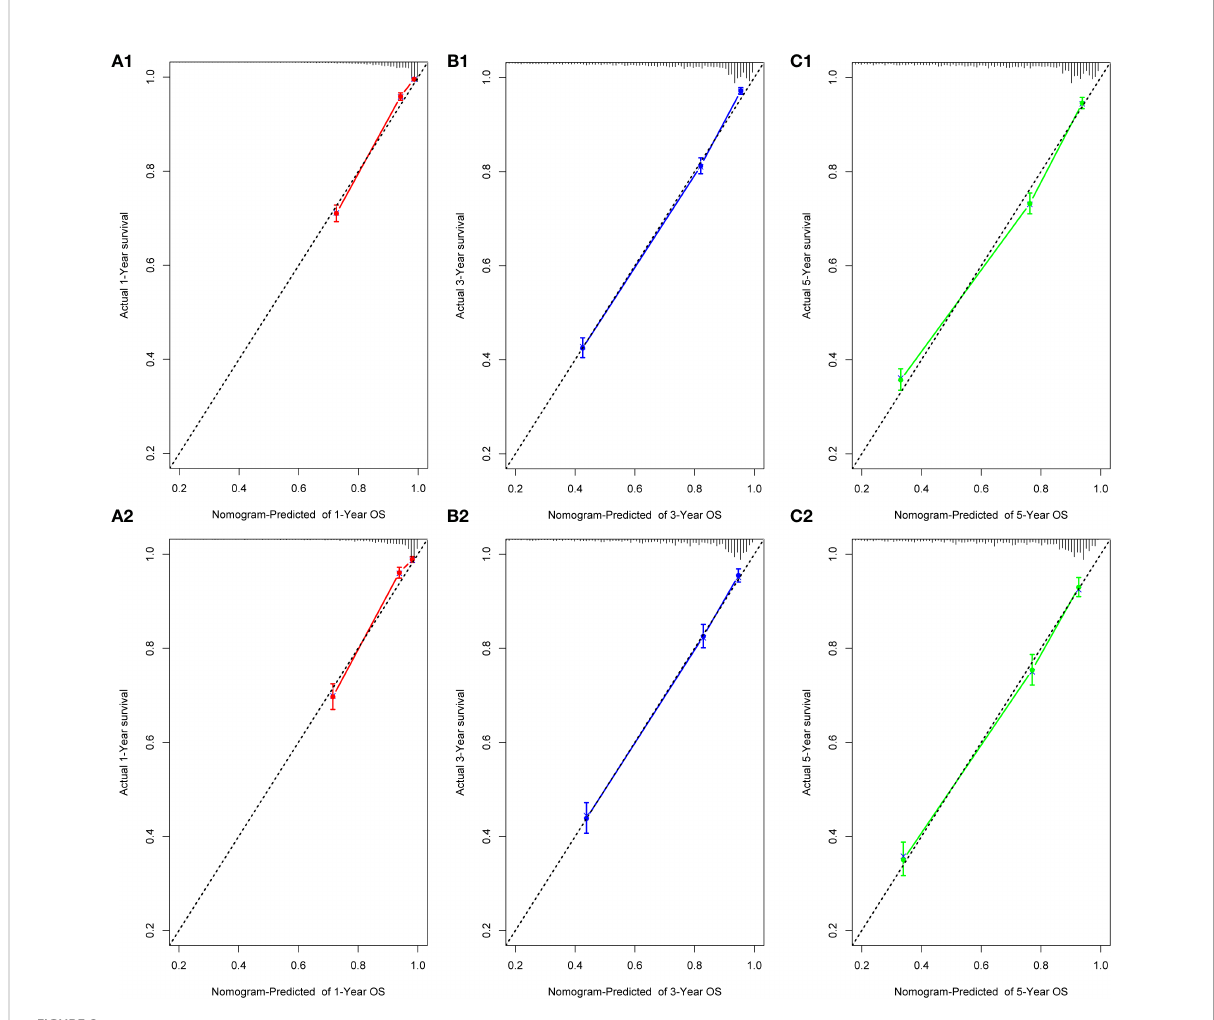
FIGURE 2 Calibration plots for 1-, 3-, and 5-year OS prediction for the training cohort ( A1, B1, C1) and validation cohort (A2, B2, C2)